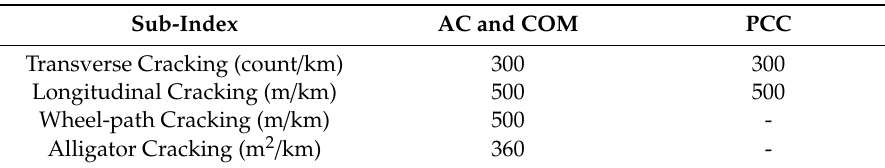
Table 2. Threshold values for the cracking sub-indices.